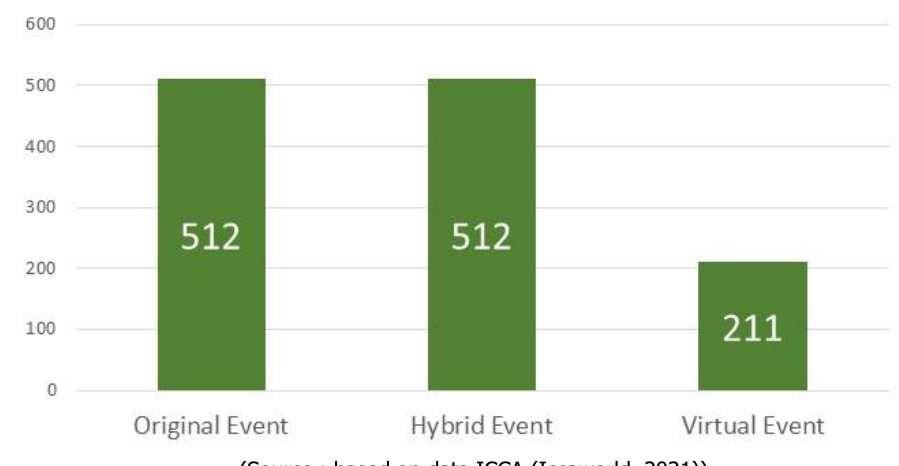
Figure.4 Lower Economic Impact Show by Registration Fee Per